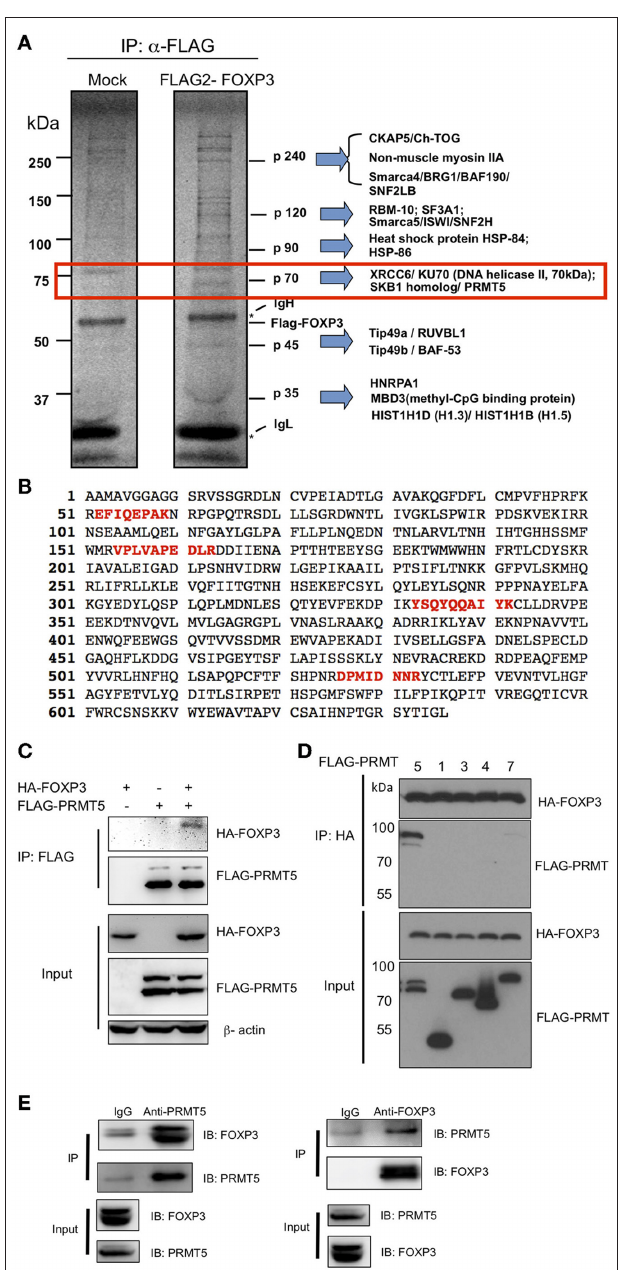
FIGURE 1 | Identification of PRMT5 as a binding partner of FOXP3. (A) mass spectrum analysis of FOXP3 binding protein. 293T cells were transfected with pIPFLAG2-FOXP3 vector and immunoprecipitated with anti-FLAG agarose beads and subjected to SDS-PAGE. The proteins were visualized using a SilverQuest silver staining kit, and specific bands in FLAG-FOXP3 samples were analyzed by LC-MS/MS. (B) 4 peptide sequences of PRMT5 (labeled in red) were identified by MS sequencing as FOXP3 bound proteins. (C,D) specific interaction of PRMT5 with FOXP3 proteins. 293T cells were transfected with HA-FOXP3 and FLAG-PRMT5 (C) or HA-FOXP3 and FLAG-PRMT1, 3, 4, and 7 (D) . (E) endogenous interactions of FOXP3 with PRMT5 in human Tregs. Expanded human Tregs were lysed and subjected to immunoprecipitation with anti-PRMT5 (left panel) or anti-FOXP3 antibody (right panel). The samples were then blotted and protein detected with indicated